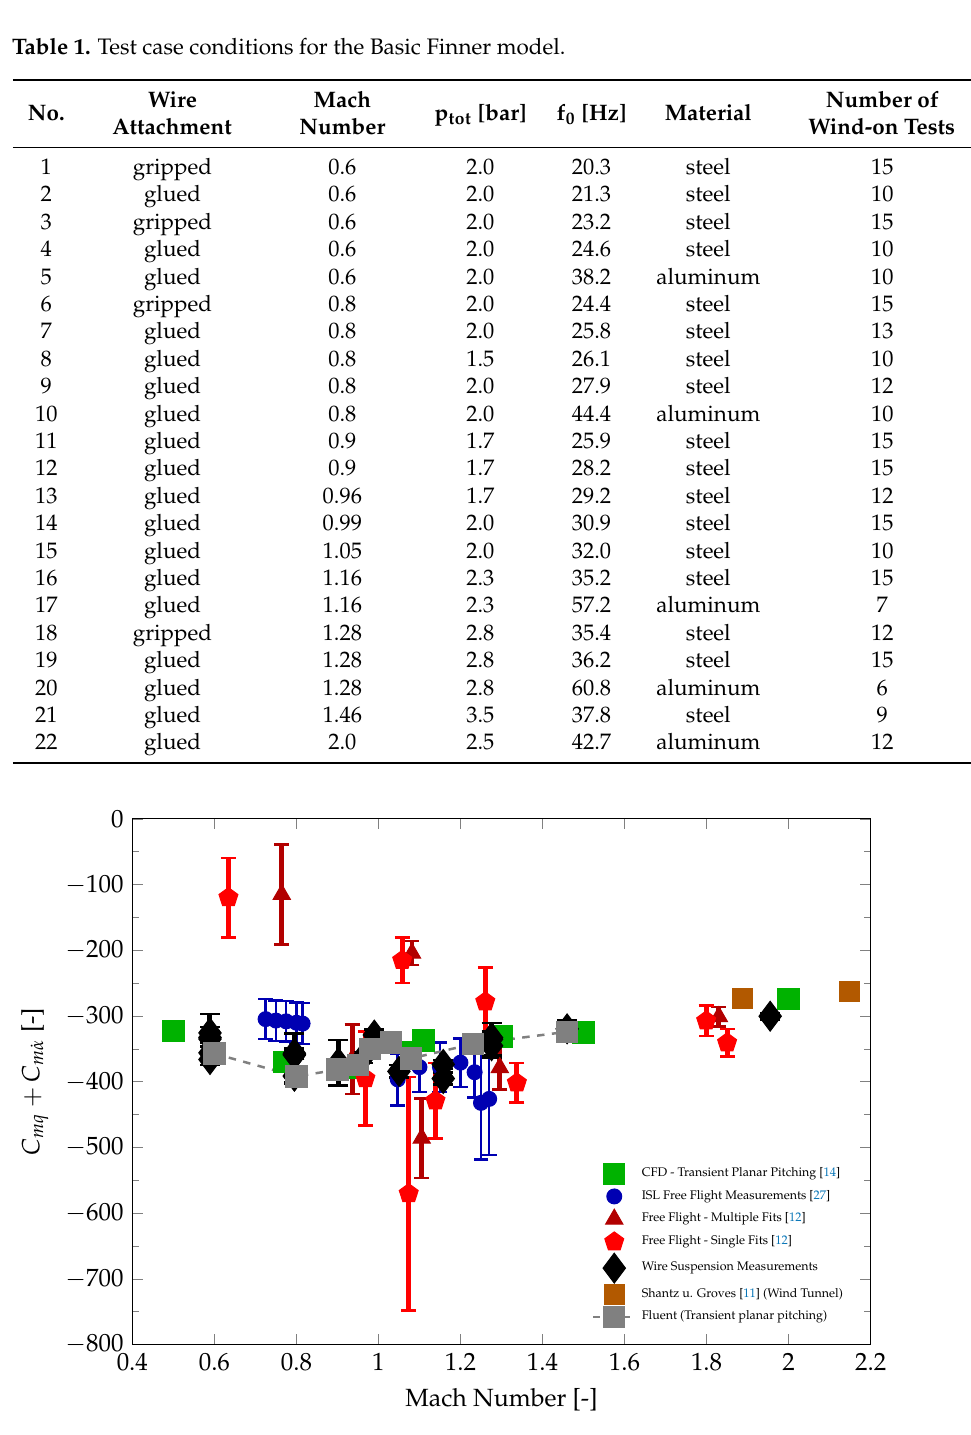
Figure 10. Wire suspension measurements in comparison with CFD and free-flight data. An excerpt from Figure 10 focusing on the transonic range is shown in Figure 11. The error bars of the free-flight measurements have been removed for clarity and different symbols are used for different model materials and wire attachment methods. In the subsonic range a decrease in C mq + C m ˙ α can be observed as the Mach number approaches 1, as it is expected based on the literature data. The experimental data indicates a